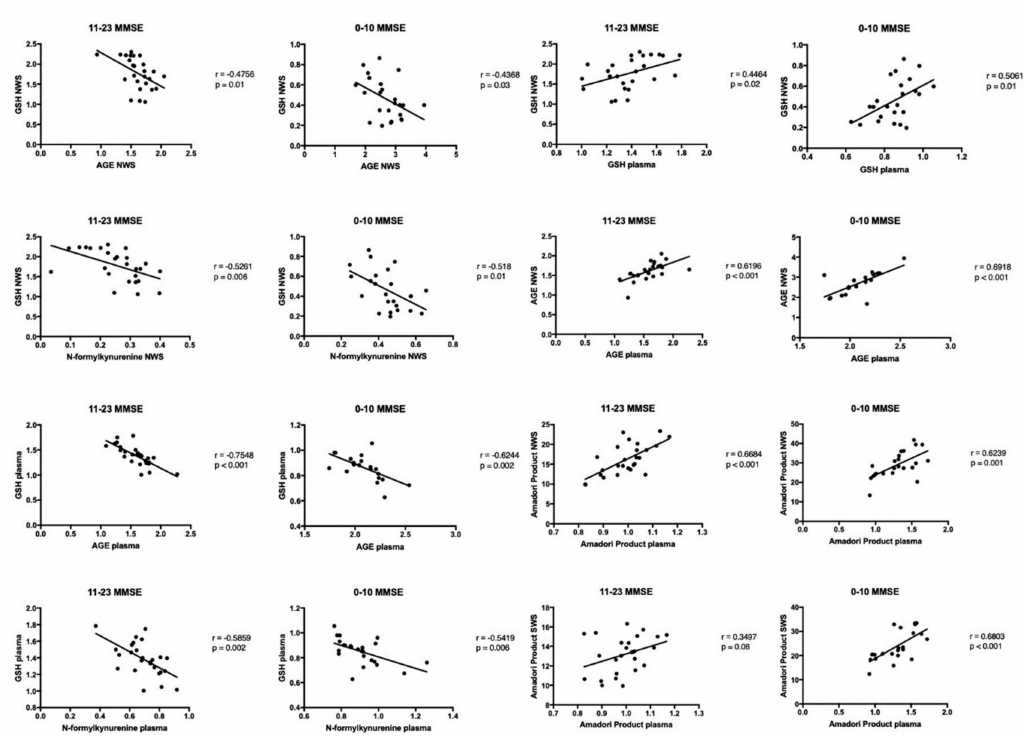
Figure 5. Correlations between oxidative stress biomarkers in dementia patients. Abbreviations: AGE—advanced glycation end products; GSH—reduced glutathione; MMSE—Mini Mental State Examination; NWS—non-stimulated whole saliva; SWS—stimulated whole